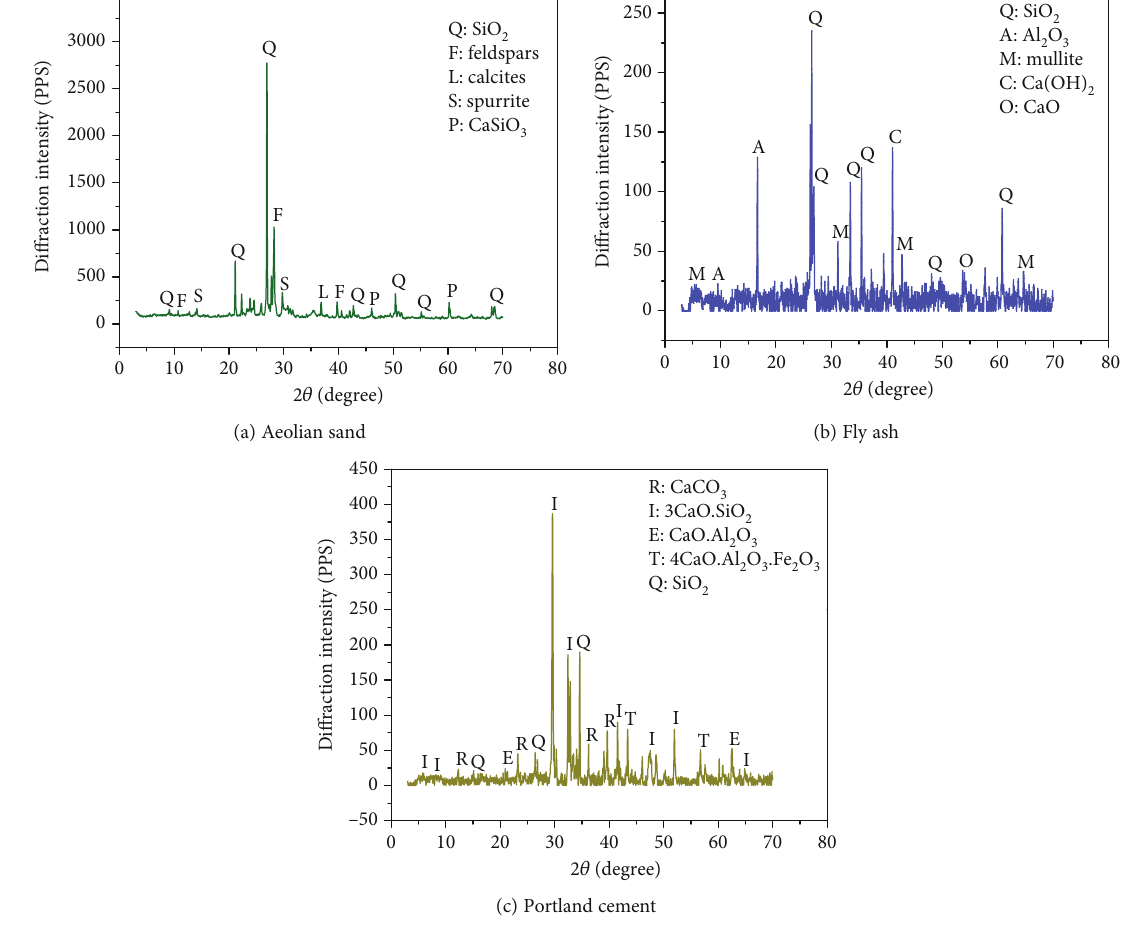
Figure 4: XRD patterns of raw materials.